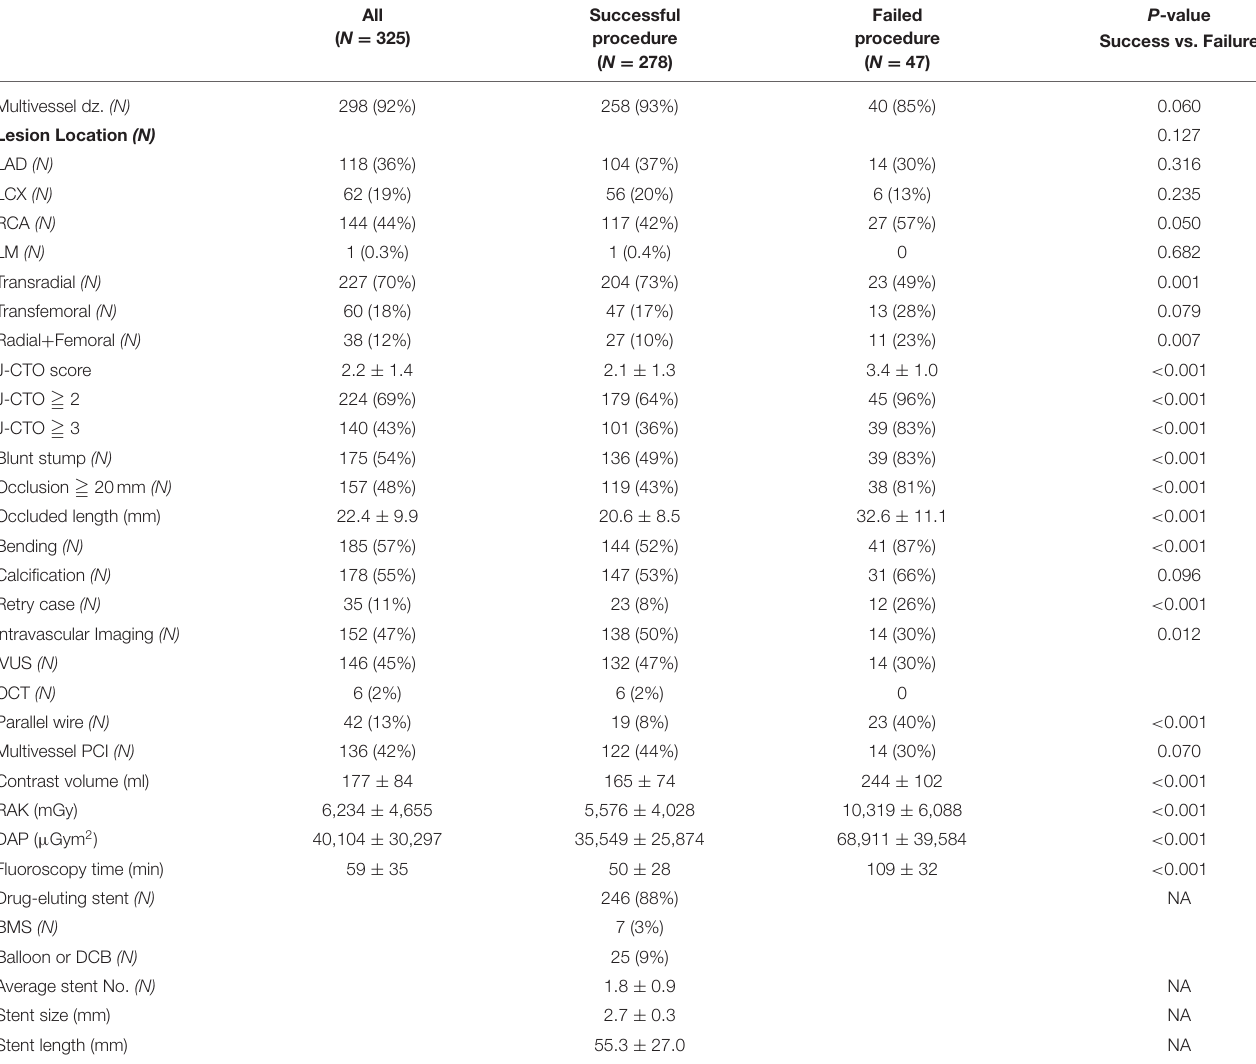
TABLE 2 | Comparisons of angiographic and procedural characteristics between successful and failed antegrade procedures.